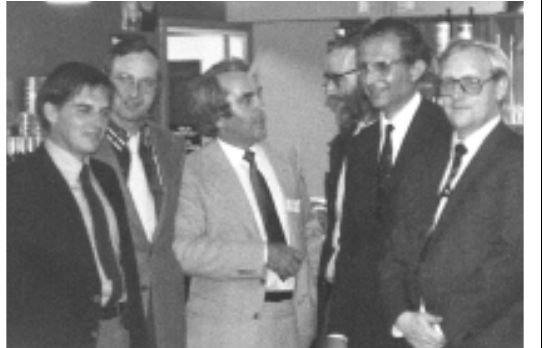
Figure 6: Annual Award of the Britisch Society of Rheo- logy (1981): H Münstedt, MH Wagner, J Meissner, FN Cogswell, JRA Pearson (BSR president), HM